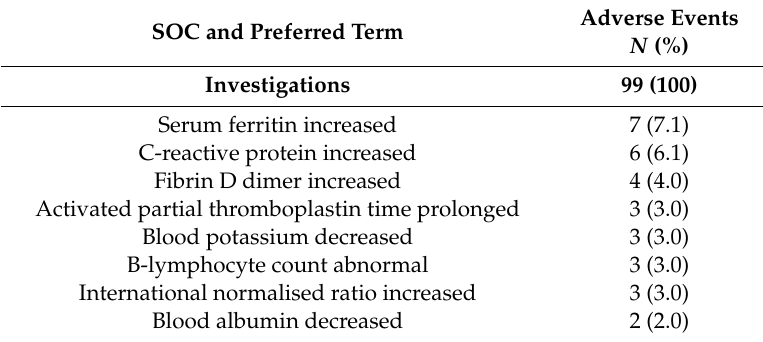
Table 3. Distribution of adverse events (at least 2) belonging to the top 6 System Organ Class (SOC) by preferred terms reported in the ICSRs involving tisagenlecleucel as the suspected drug.